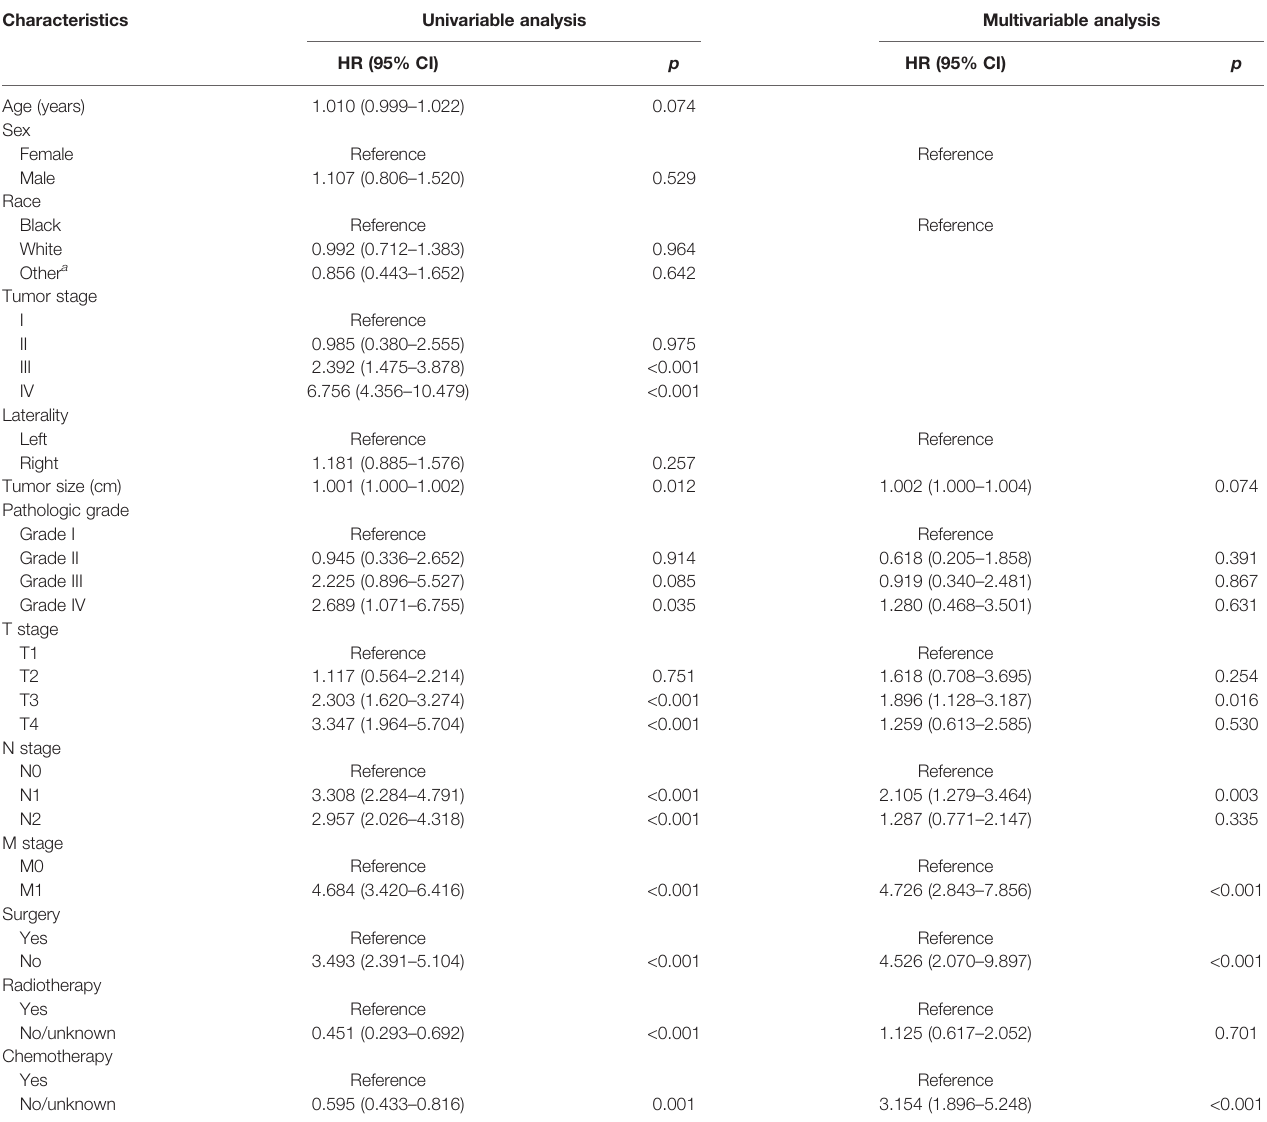
TABLE 1 | Univariate and multivariate Cox regression analysis of the associations between clinicopathological features and OS in patients with CDCs.